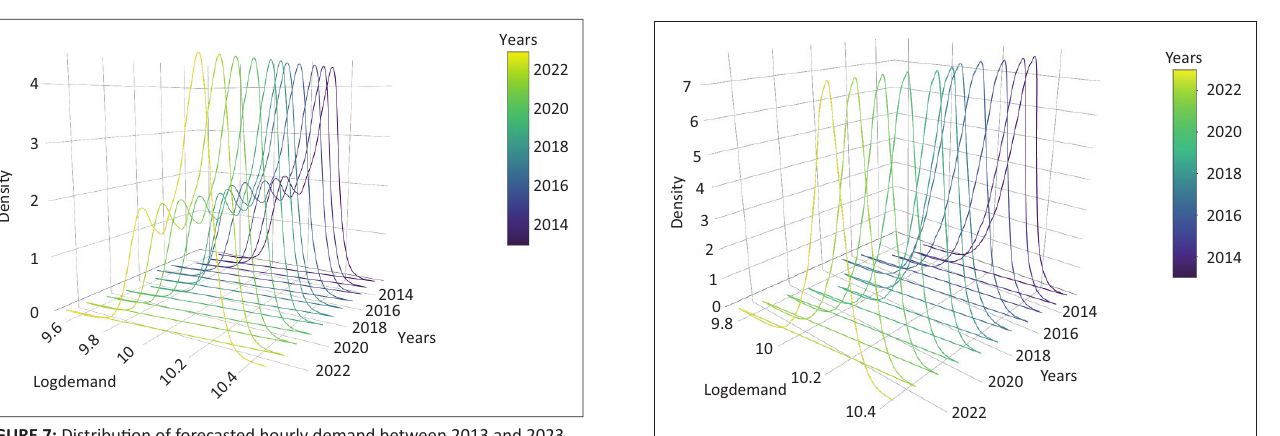
FIGURE 7: Distribution of forecasted hourly demand between 2013 and 2023.